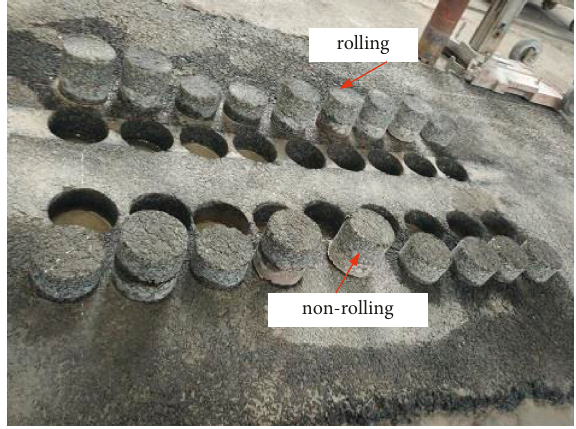
Figure 14: Core specimens. Table 8: Bulk specific densities and indirect tensile strengths of two types of core specimens.